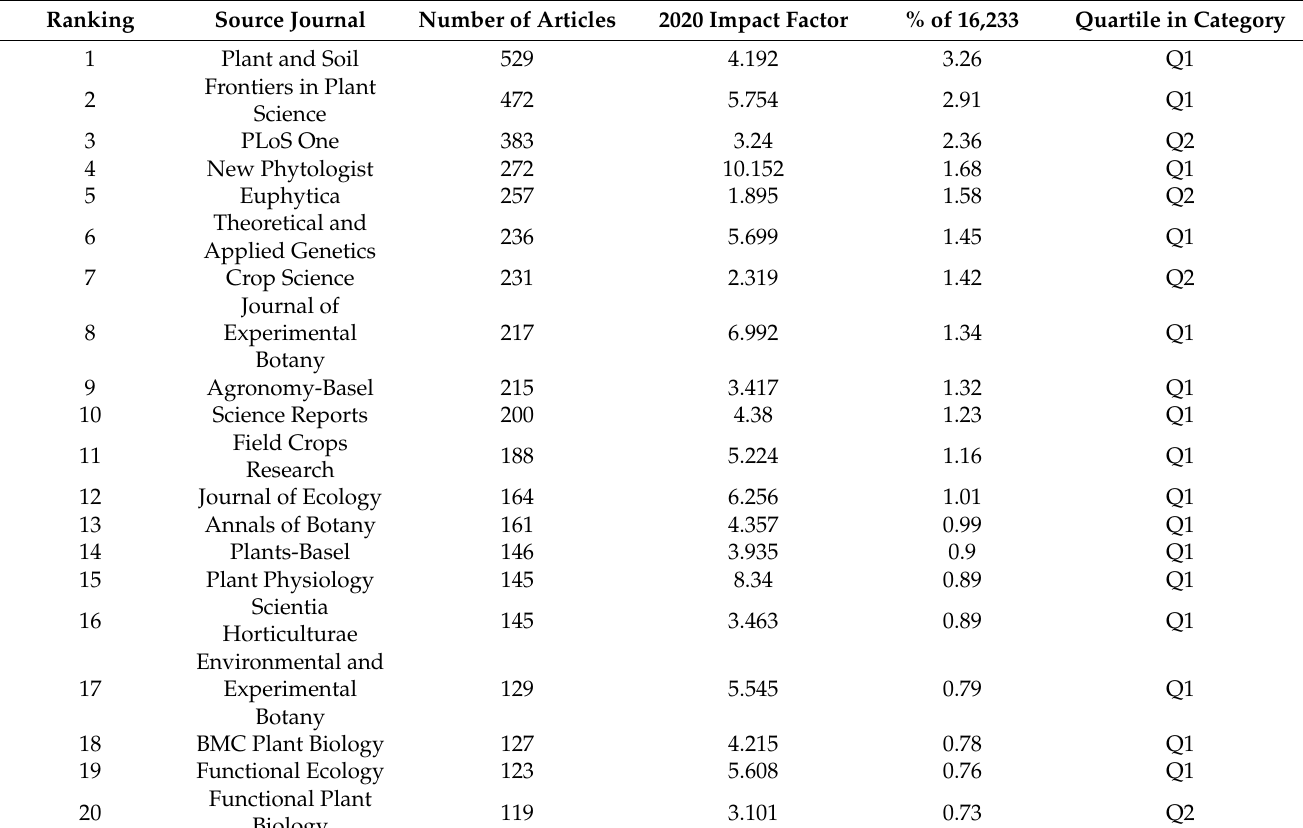
Table 1. Top 20 journals by the number of articles published from 2000 to